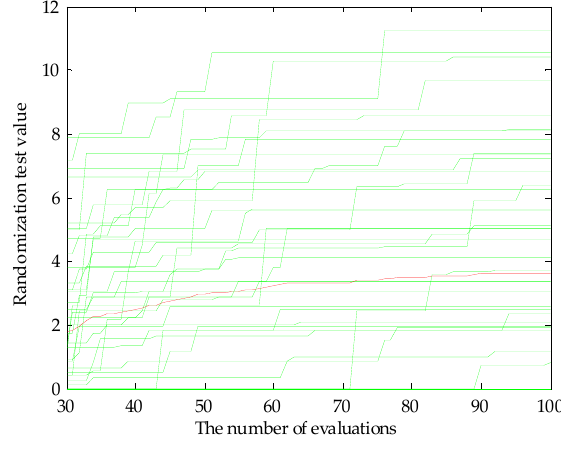
Figure 5. Randomization test result.